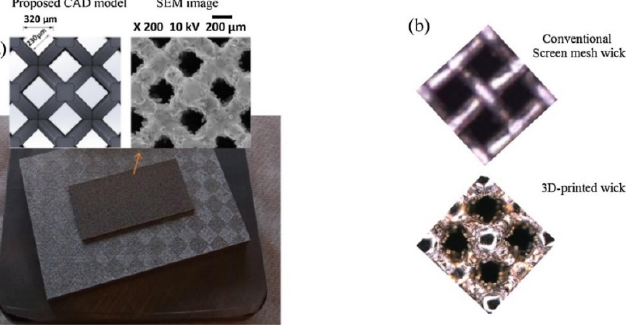
Figure 15. CAD model and SEM images for different manufacturing processes [79]: ( a ) additively manufactured wicks; ( b ) conventional wicks.